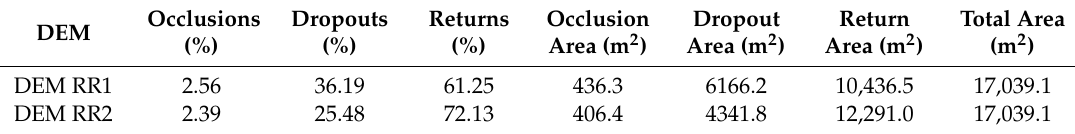
Table 2. Results of data gap classification for the cropped Rabbit Rock DEMs 1 and